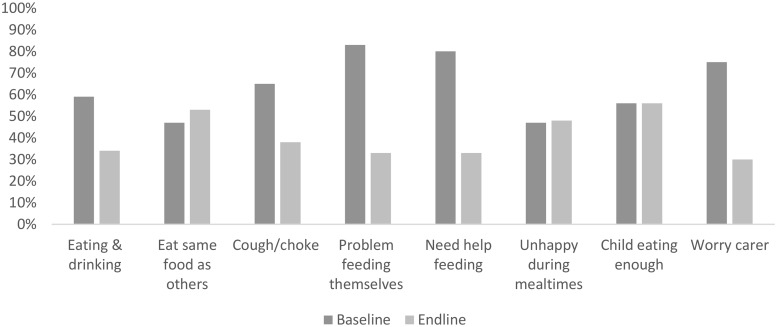
Proportion of caregivers reporting problems always/often with different aspects of child’s feeding at baseline and endline.